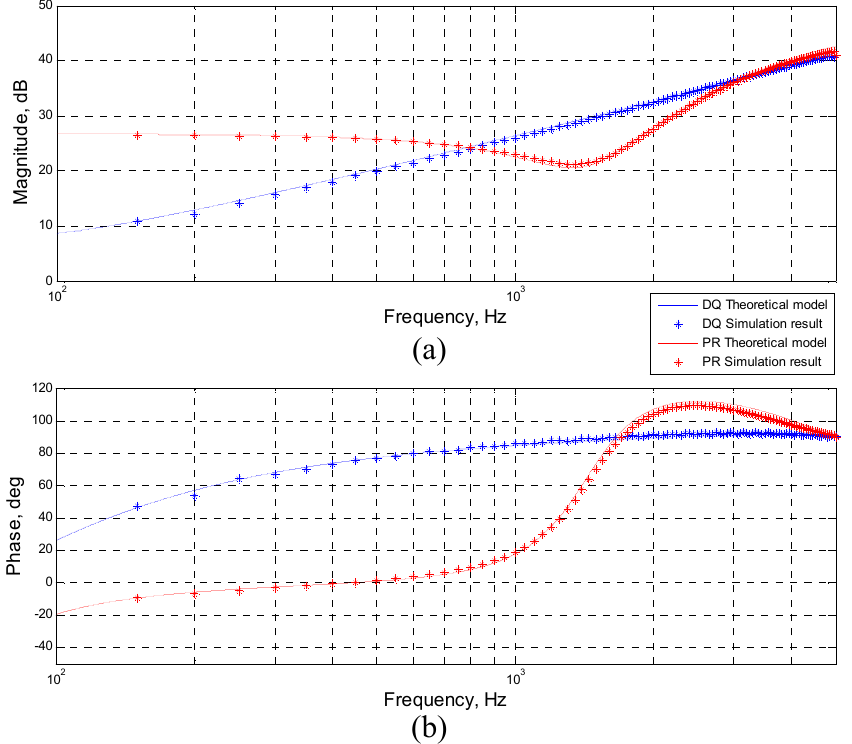
Figure 10. The Bode diagram of the inverter output impedance. ( a ) Impedance amplitude ( b ) Impedance phase angle; the solid line for theoretical calculation; * for simulation result; red for dq-based control and blue for PR-based control. Appl. Sci. 2019 , 9 , x FOR PEER REVIEW